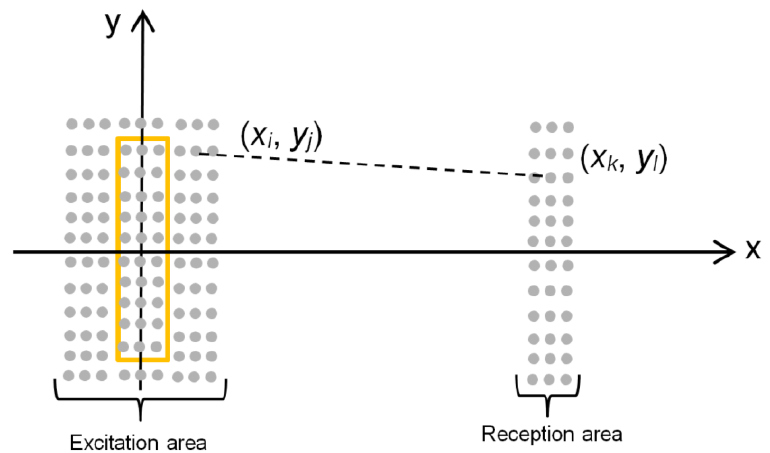
Figure 12. Excitation and reception areas.